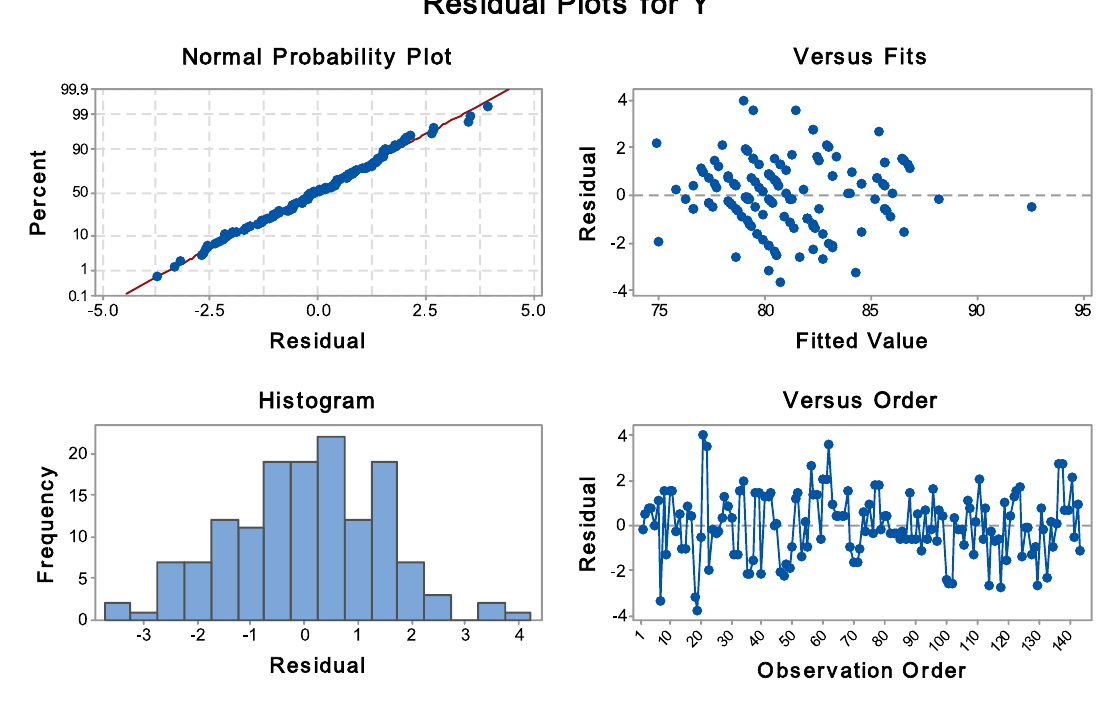
Fig. 6 Residual plots in model fitting for the first interval